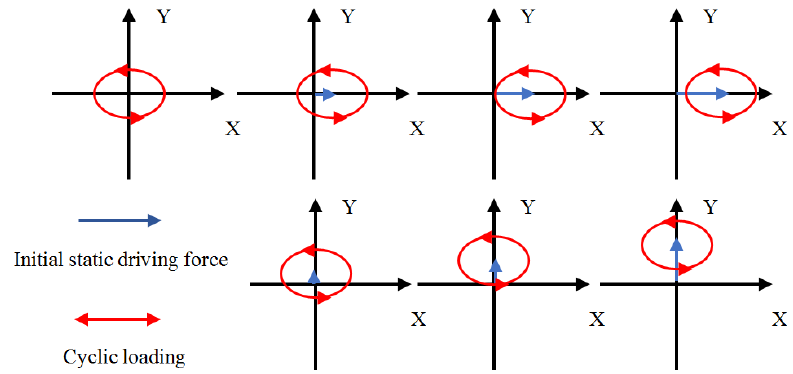
Figure 8. Different levels of stress reversals in tests with varied stress paths, by Kammerer (Reprinted from [37]).